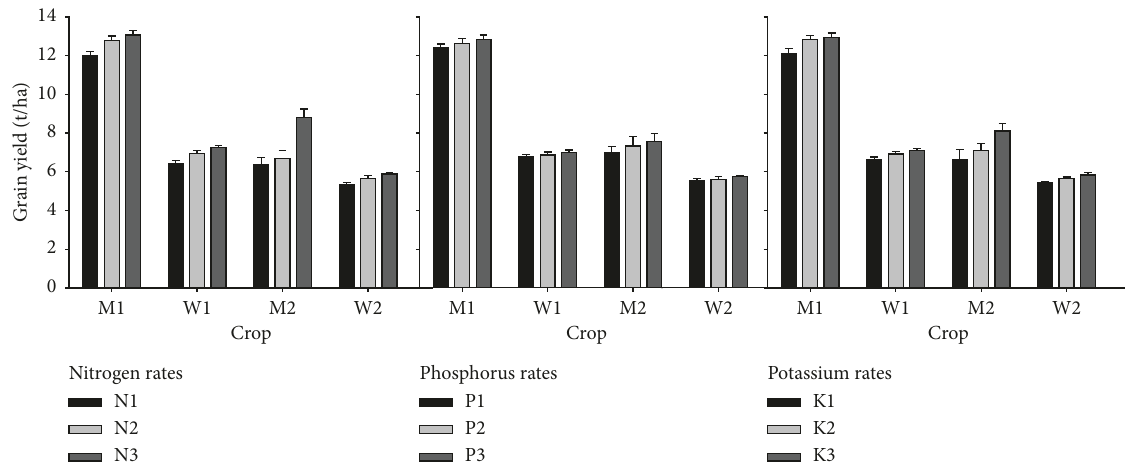
Figure 2: Mean grain yields of maize and wheat in different fertilization treatments during four successive crop seasons at Khumaltar, Lalitpur, Nepal (2019/20–2020/21). M 1 crop in 2nd